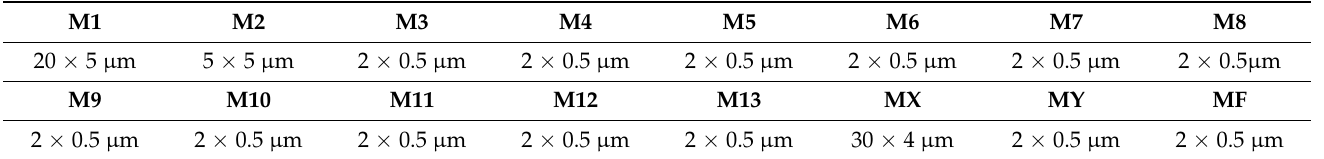
Table 1. Device sizes summary of the implemented LNAs.